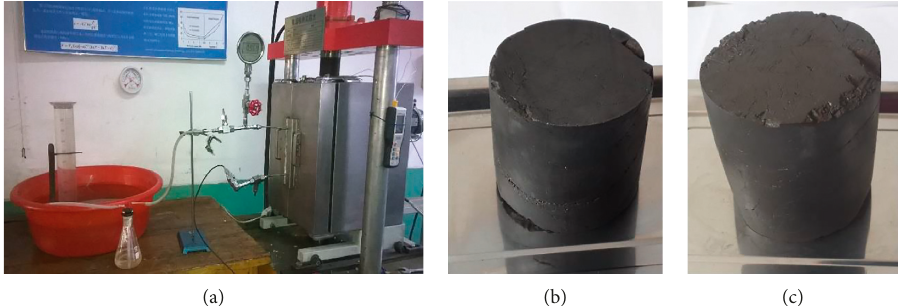
Figure 1: Experimental apparatus and coal samples used in these experiments. (a) Experimental apparatus. (b) Coal sample #1. (c) Coal sample #2.